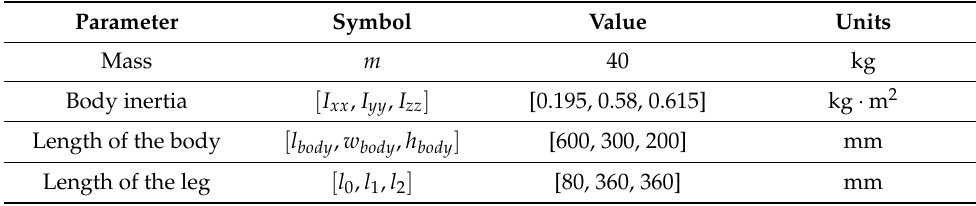
Figure 7. Quadruped Robot BQR3. Table 1. The parameters of the BQR3